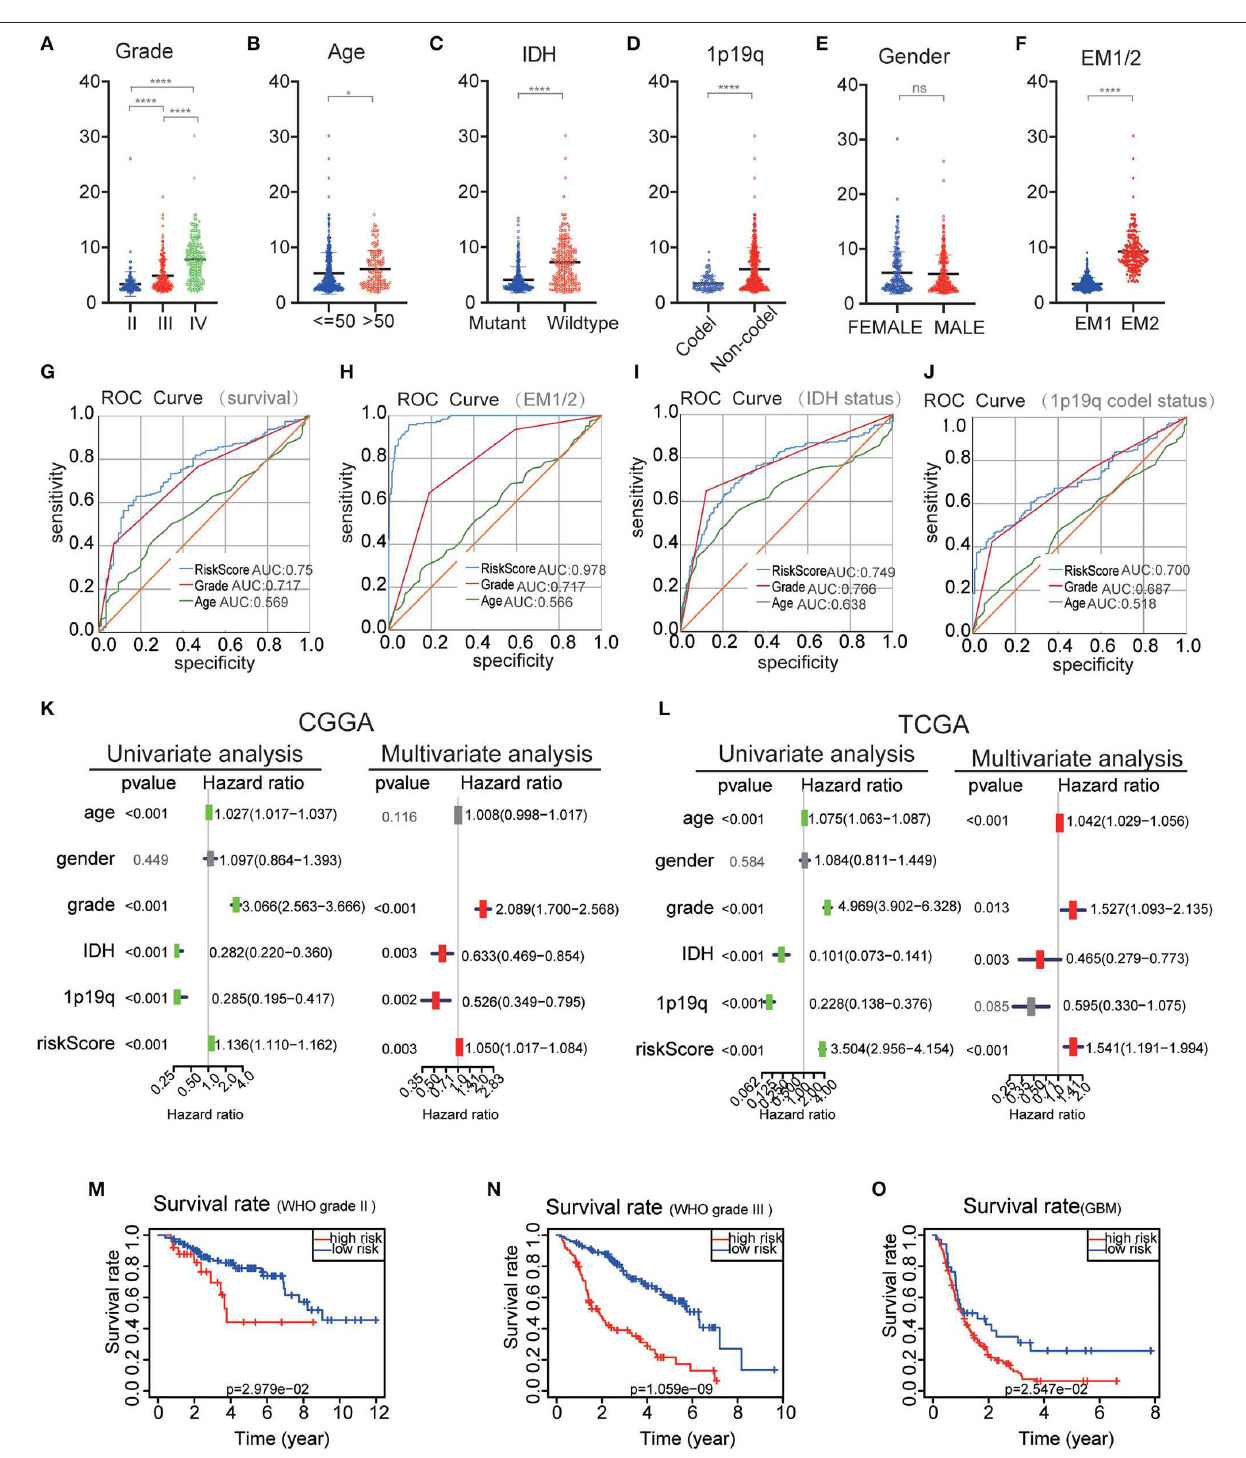
Frontiers in Oncology | www.frontiersin.org